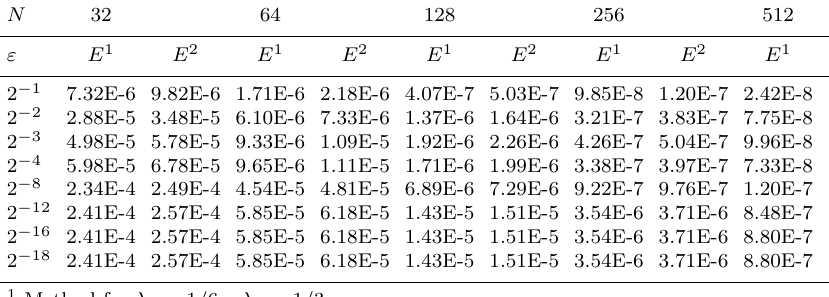
Table 3. Maximum absolute error ( E ) for Example 2 with δ = 0 . 5 ε N